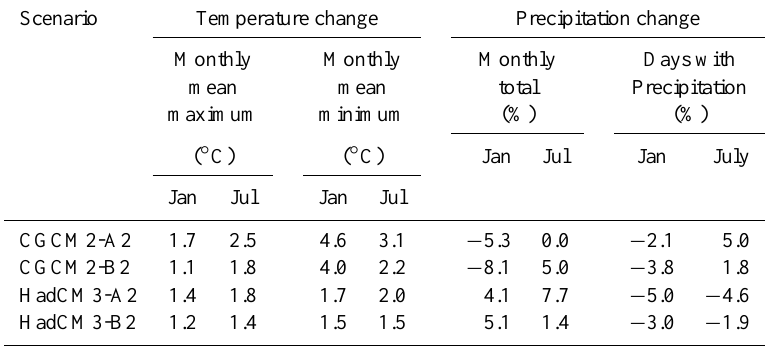
Table 6. Temperature and precipitation changes for the future period (2040–2069) relative to the historical period (1971–2000) for each selected climate change scenarios at the Charlottetown weather station, Prince Edward Island (Qian and De Jong,